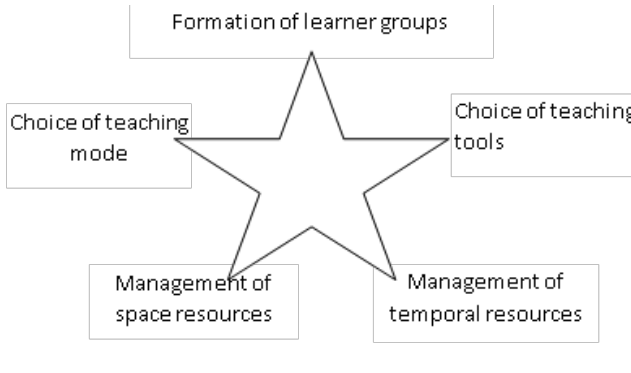
Figure 3. Organizational actions in educational environment